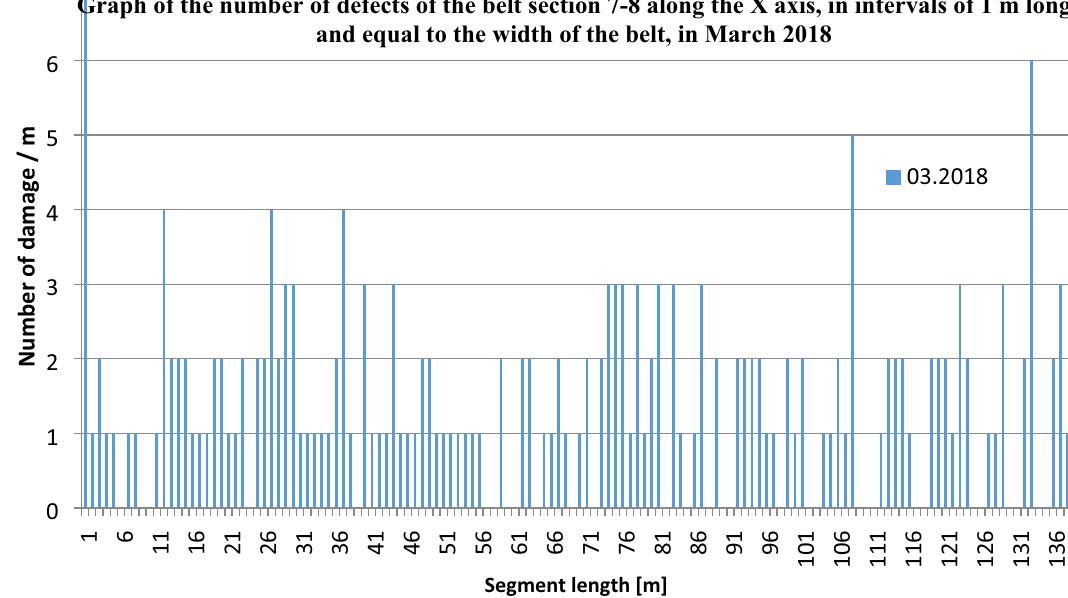
Figure 6. Damage density in 1-m-long belt segments along belt axis, for the analysed belt Sect. 7–8—state of March 2018 (4th measurement) 5,42 (Microsoft Excel, version 2010, own data).